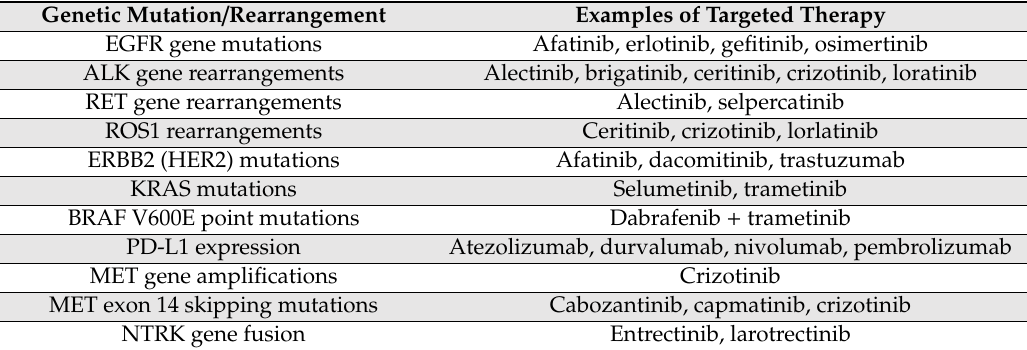
Table 1. Examples of genetic mutations / rearrangements identified in non-small-cell lung cancer (NSCLC)